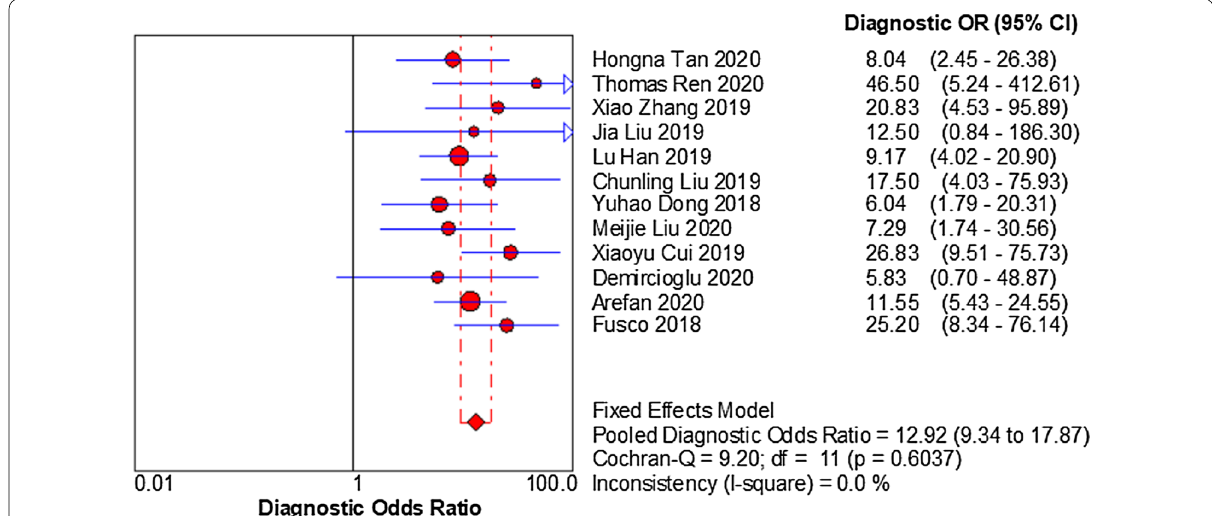
Fig. 3 A forest plot of single studies for the pooled diagnostic odds ratio and 95% confidence interval (CI) in the validation group. Horizontal lines represent the 95% CI of the point estimates. Each red circle represents the area under the curve (AUC) of the individual studies, and the box size indicates the study size. The red diamond indicates the pooled AUC of all twelve studies